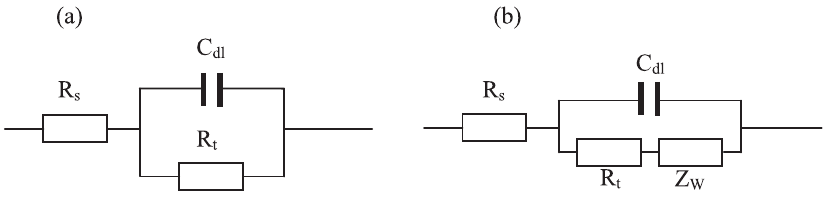
Fig. 6: Equivalent circuits fitting the impedance spectra for the corrosion of both Fe and Ni (a) and of Cr